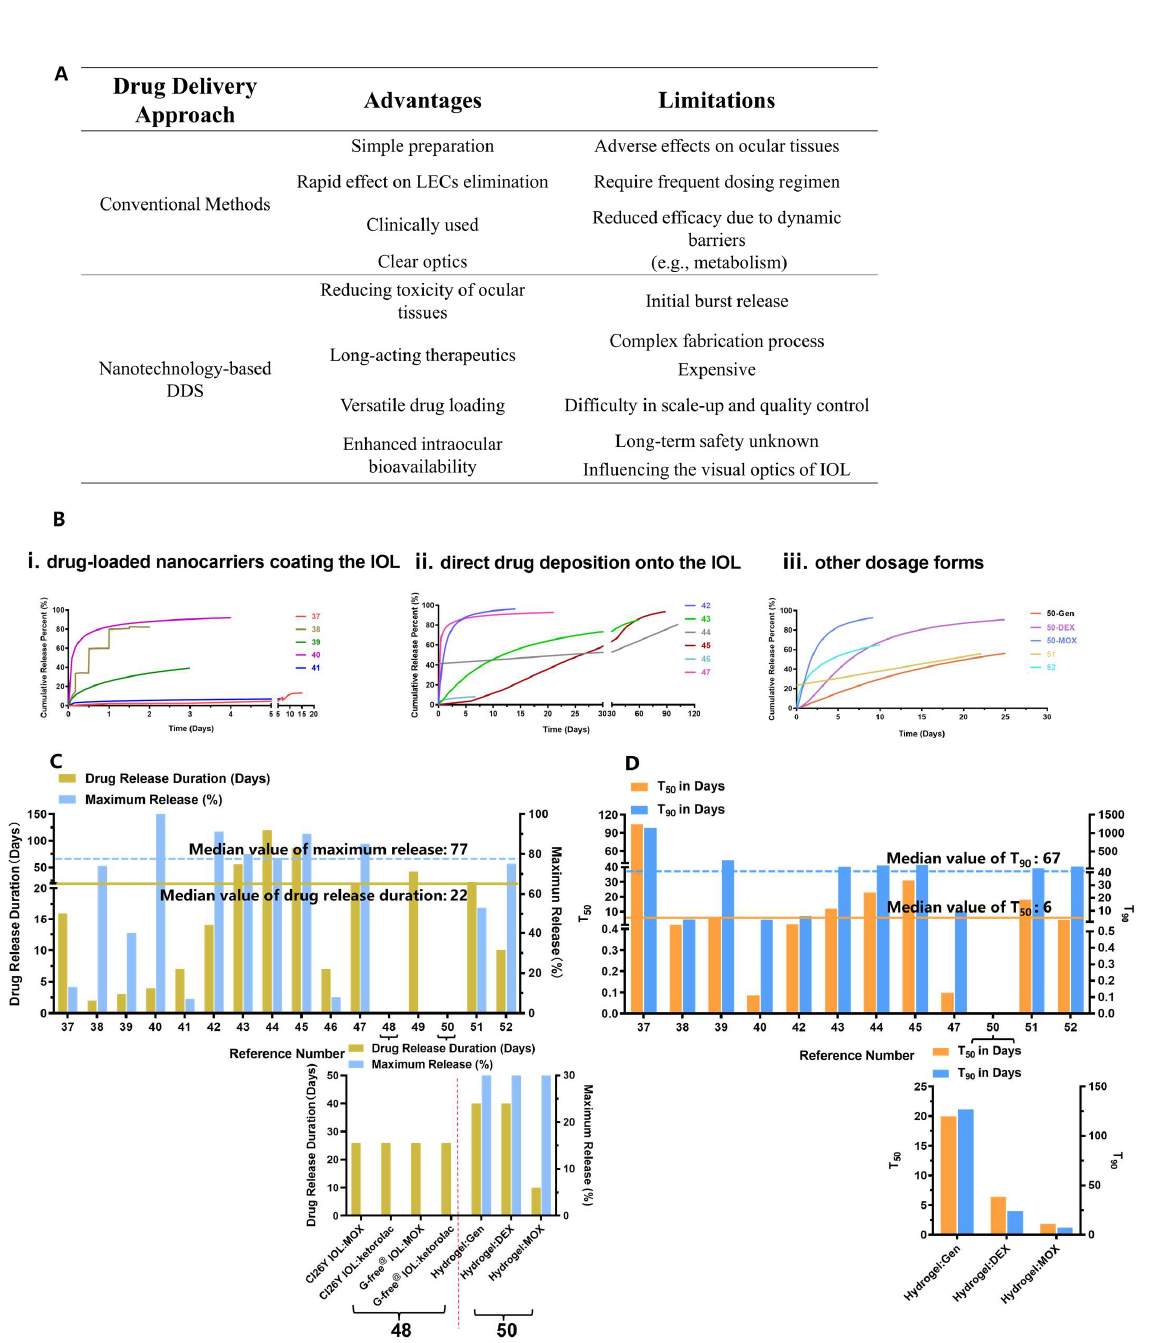
Figure 3. Analysis of prophylactic drug delivery strategies for PCO. ( A ) Advantages and limitations of conventional and nanotechnology-based drug delivery; ( B ) Fitted drug release profiles of anti-PCO DDSs shown in Table 2, including ( i ) drug-loaded NPs coating the IOL; ( ii ) direct drug deposition onto the IOL and ( iii ) non-IOL DDSs, including NPs, hydrogel and implants. The number shown on the X-axis corresponds to reference numbers in Table 2, and left- and right- y axis are drug release duration and maximum release percent, respectively; ( C ) Drug release duration and maximum drug release percent of nanotechnology-based DDS; ( D ) The time t 50 and t 90 when the fraction of drug release reached 50% and 90%, respectively, for nanotechnology-based DDSs. Note, ( i ) the data on “drug release duration” for references [48,49] were shown in Figure 3C, and not displayed in Figure 3B,D due to lack of data on drug release; ( ii ) the data on t 50 and t 90 for references [41,46] were too large to display in the graph in Figure 3D, and references [48,49] did not provide sufficient data for calculating t 50 and t 90 . ( iii ) X-axes of the two graphs in Figure 3C,D represent the data on drug